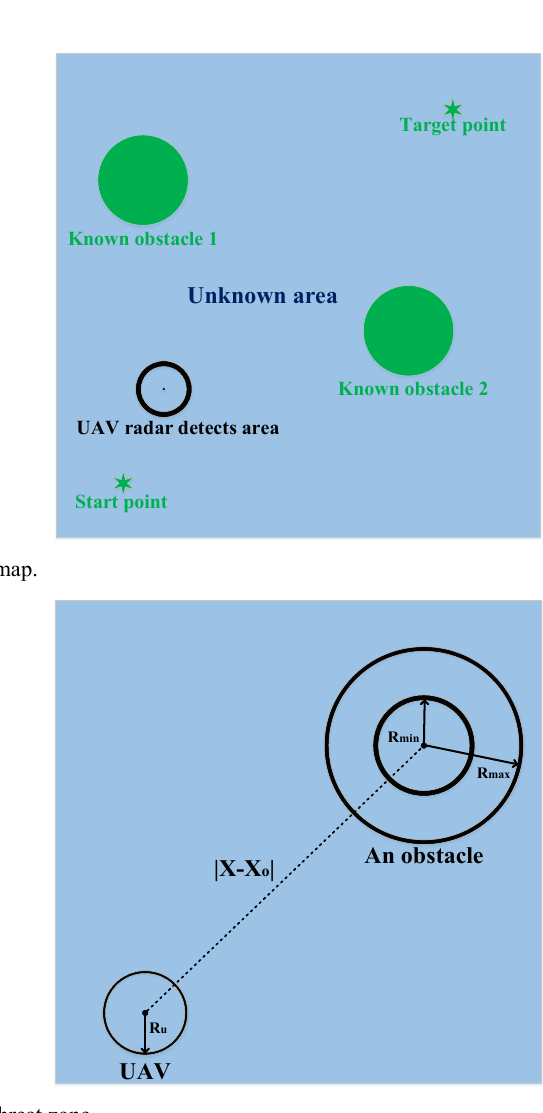
Fig. 2. UAV radar threat